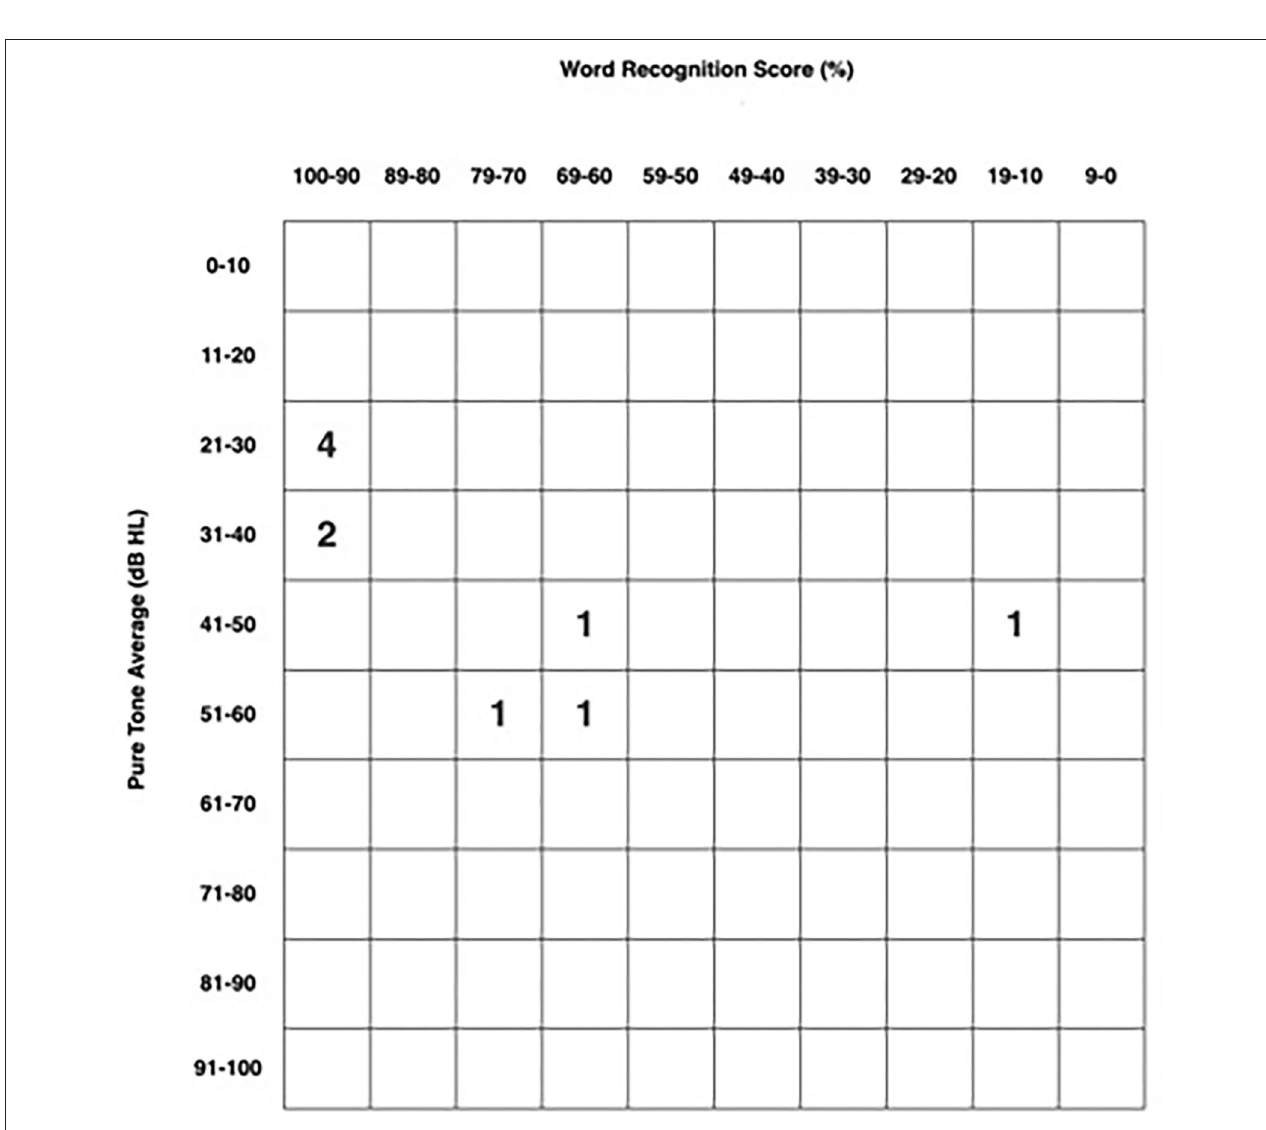
FIGURE 3 | Standardized audiometric scattergram of 10